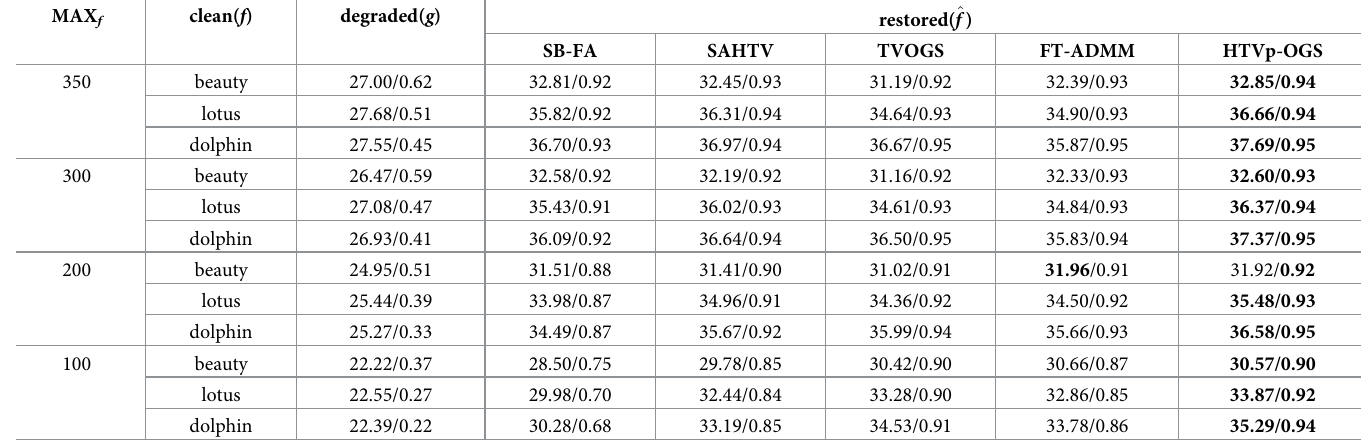
Table 2. The PSNR and SSIM values for the Poisson image restoration by different methods in the case of the Gaussian blur with kernel size 9 × 9 and variation 1.